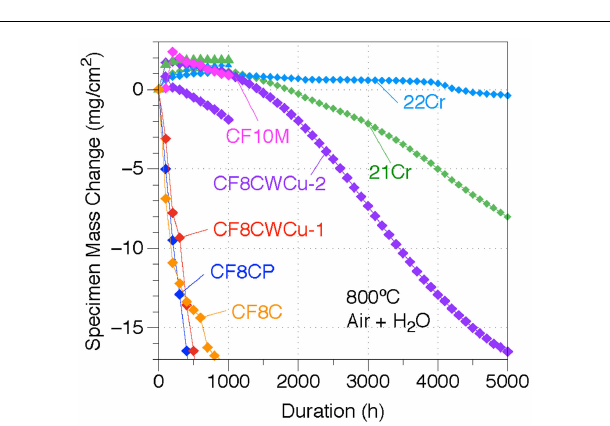
FIGURE 9 | Mass change curves for alloys CF8C, CF8CP, CF10M, CF8CWCu-1, CF8CWCu-2, 21Cr–15Ni, and 22Cr–17.5Ni exposed in air0 +++ 10% H 2 O at 800°C for 1000h for alloys CF8C and CF10M and 1000 and 5000h for all the other alloys .